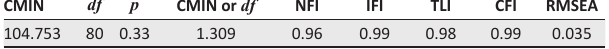
TABLE 2: Goodness-of-fit measures of the measurement model in the study.